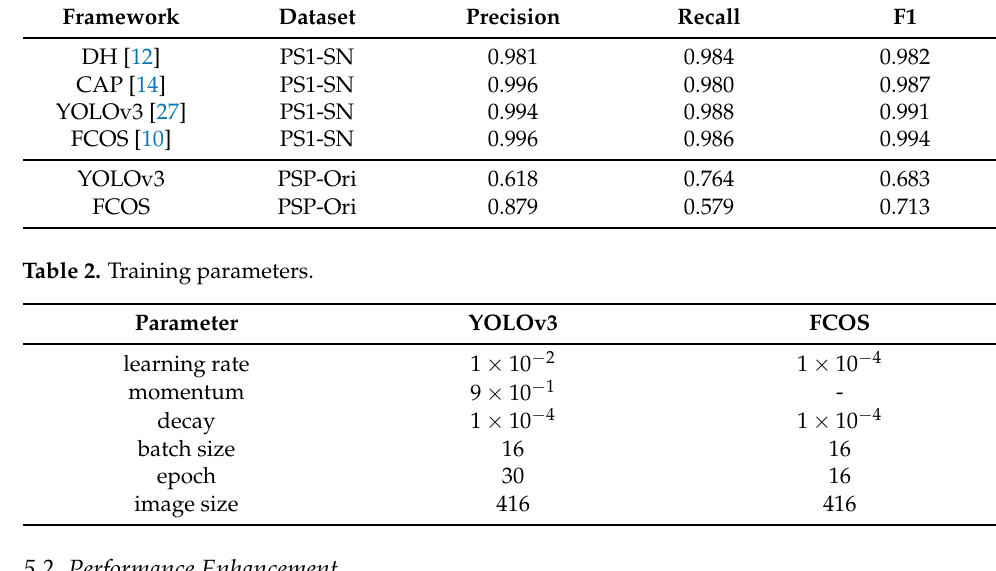
Table 1. The results of the different methods on the two datasets.